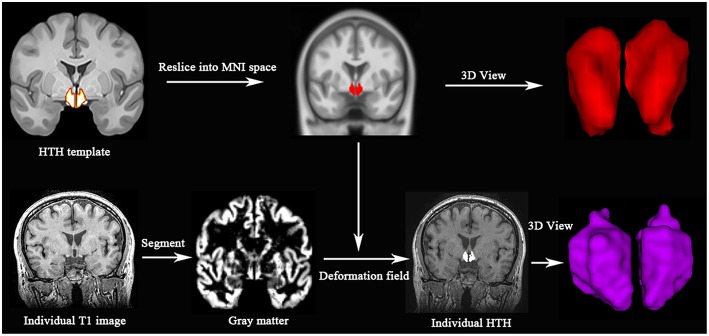
Individual HTH segment. Top line: high resolution probabilistic in vivo HTH template was resliced into MNI space; Bottom line: Individual T1 images were segmented, and generated deformation field, which would be used to generate individual HTH using pull-back strategy. Red and purple represent 3D visualization of HTH template and individual HTH.